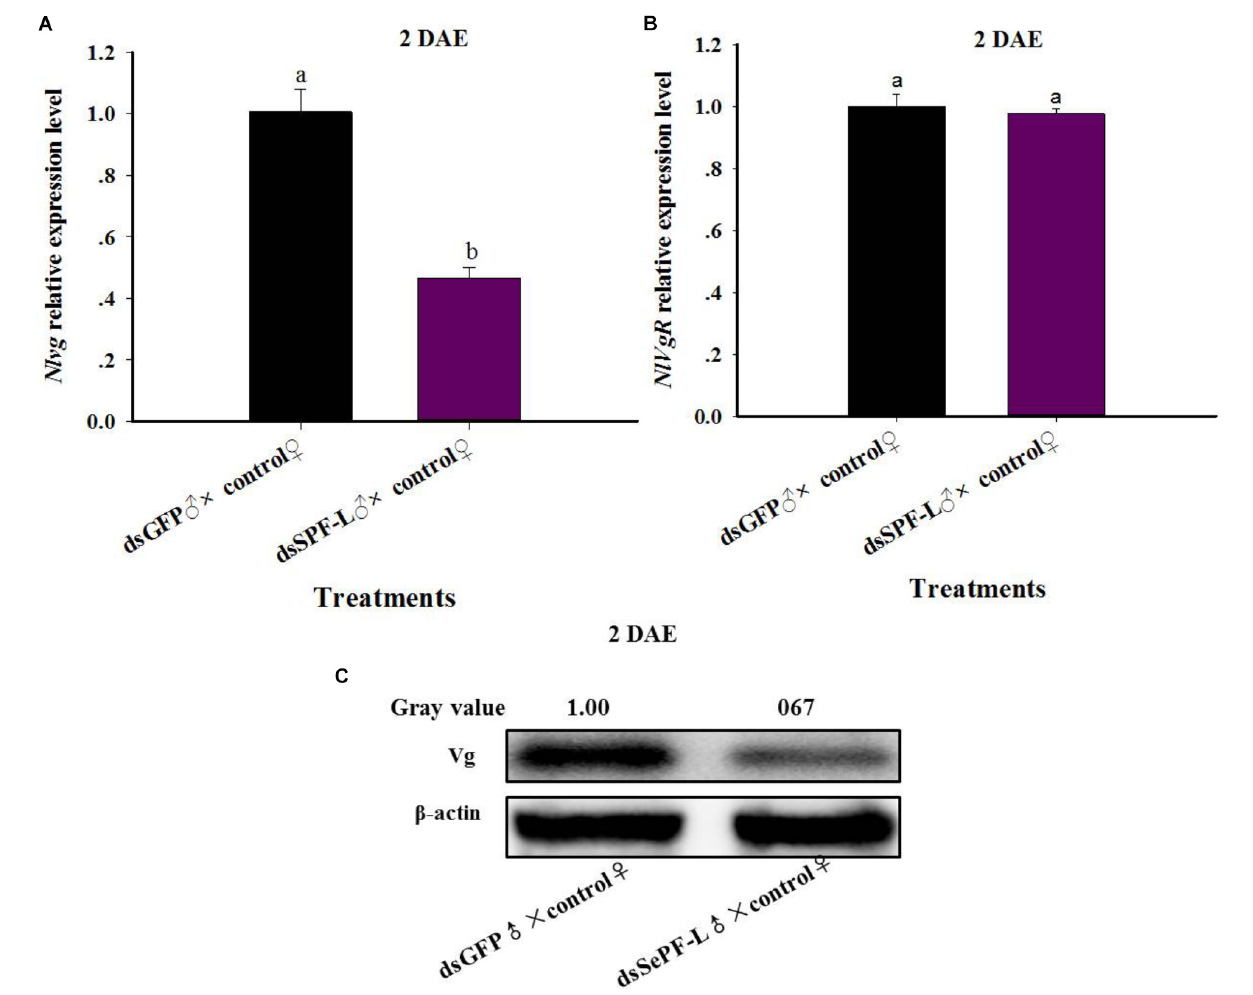
FIGURE 7 | The influence of mating with dsSPF-Ltreatedmales on accumulations of mRNAs encoding Vg, VgR, and Vg protein synthesis. (A) The histogram bars show mean NlVg expression level at 2 DAE ( n = 5, N = 3). (B) The histogram bars show mean NlVgR expression level at 2 DAE ( n = 5, N = 3). (C) Western blot analysis of mating with dsSPF-L-treated males led to reduced fat body Vg protein levels of Vg using antibody-rabbit Vg in at 2 DAE ( n = 5, N = 3). β -actin antibody was used as the loading control. The relative gray values normalized to β -actin were marked above corresponding bands. The relative gray values of dsGFP treatment was looked on as 1. The histogram bars with different letters were significant difference at p < 0.05 (Student’s t